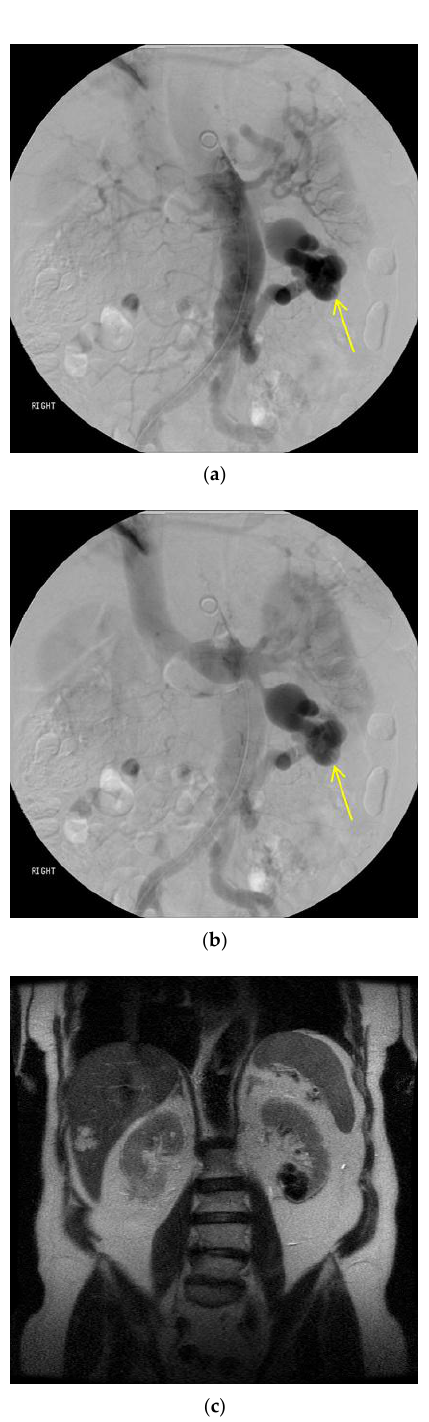
Figure 3. Catheter angiography of renal AVM. A nidus is detectable on catheter angiography by being visible on both arterial and venous phases of circulation. The AVM was located within the lower pole of the left kidney. The single feeder artery was from the distal abdominal aorta originating below the inferior mesenteric artery. There was a single draining vein into the left renal vein. This indicates a single shunt between arterial and venous circulation, Yakes type Ia or Cho-Do type I. ( a ) The image shows the presence of a nidus during the mid-arterial phase. ( b ) The image shows the nidus present in the mid-venous phase. ( c ) A magnetic resonance angiography (MRA) image confirms the involvement of the renal parenchyma in the area of the AVM, with a cystic lesion present in the lower pole of the left kidney, proximal to the site of the